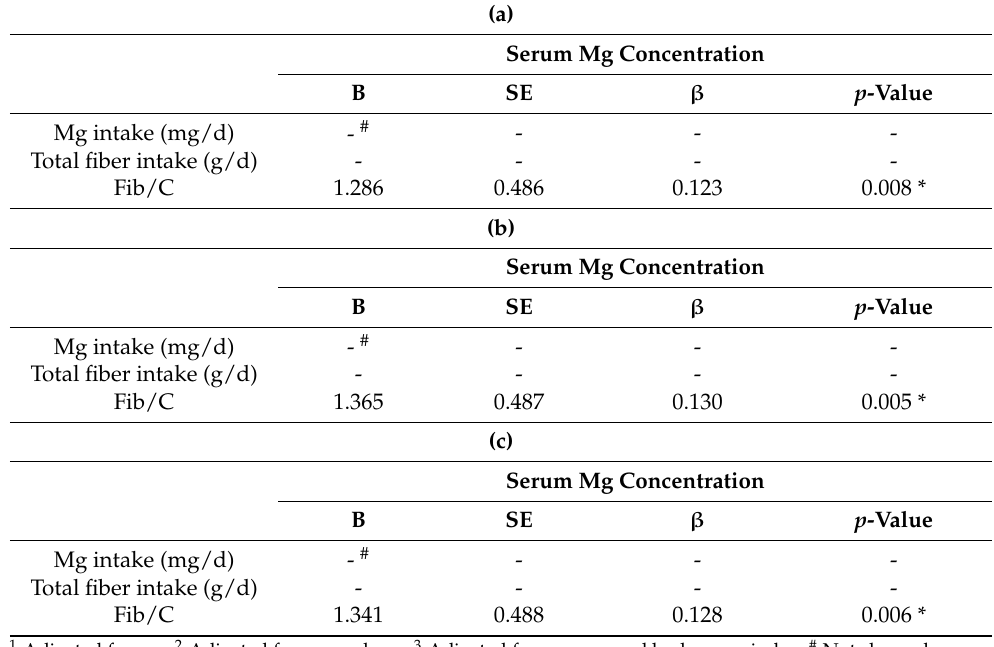
Table 5. ( a ) Results from multiple linear regression models adjusted for sex examining the association of serum Mg concentration with Mg intake, total fiber intake and Fib/C ratio 1 . ( b ) Results from multiple linear regression models adjusted for sex and age examining the association of serum Mg concentration with Mg intake, total fiber intake and Fib/C ratio 2 . ( c ) Results from multiple linear regression models adjusted for sex, age and body mass index examining the association of serum Mg concentration with Mg intake, total fiber intake and Fib/C ratio 3